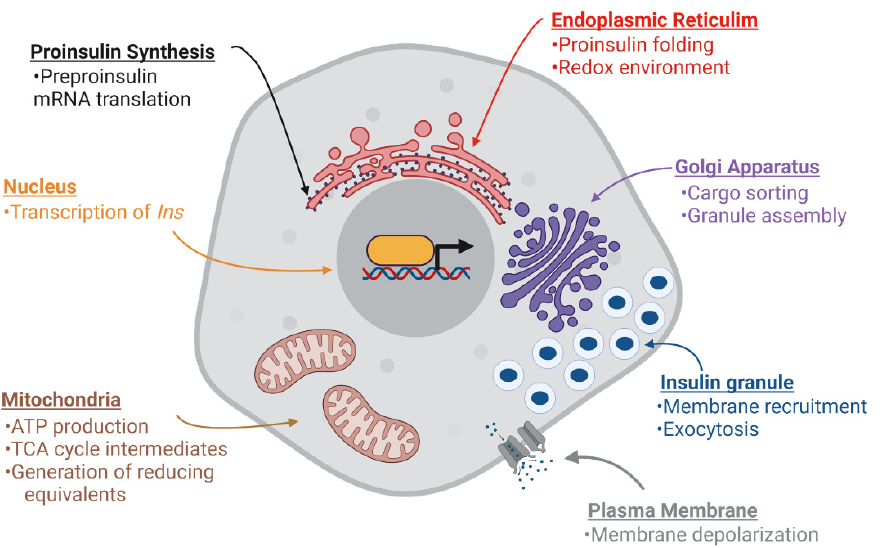
Figure 2. Nutrient metabolism supports β -cell function. Multiple stages of insulin production and secretion are regulated by mitochondrial metabolism through the generation of signaling molecules, adenosine triphosphate (ATP), tricarboxylic acid (TCA) cycle intermediates, and reducing equiva- lents. Long-term (>12 h) glucose stimulation can enhance INS expression through transcription and preproinsulin mRNA stability. Acute (<4 h) glucose stimulation can activate preproinsulin mRNA translation as well as support proinsulin folding in the ER by supplying reducing equivalents, such as glutathione. In addition, glucose can facilitate insulin granule assembly and export from the Golgi. Finally, glucose-derived signals can trigger plasma membrane depolarization and promote insulin granule fusion and insulin exocytosis. Images were created using Biorender.